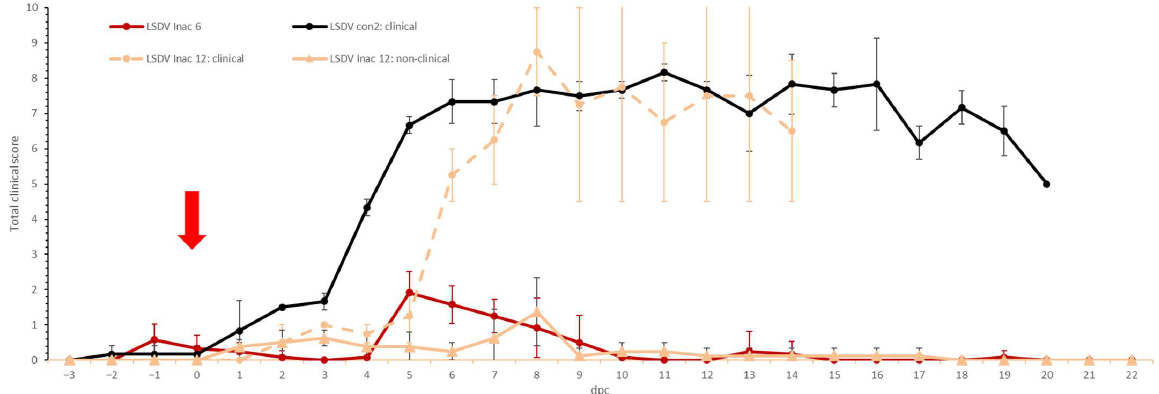
Figure 7. Averaged total clinical scores of the LSDV Inac groups after challenge. For comparative purposes: the average of the clinical animals of control group LSDV con2 was added. The red arrow indicates the moment of challenge, and standard deviation is shown as error bars.